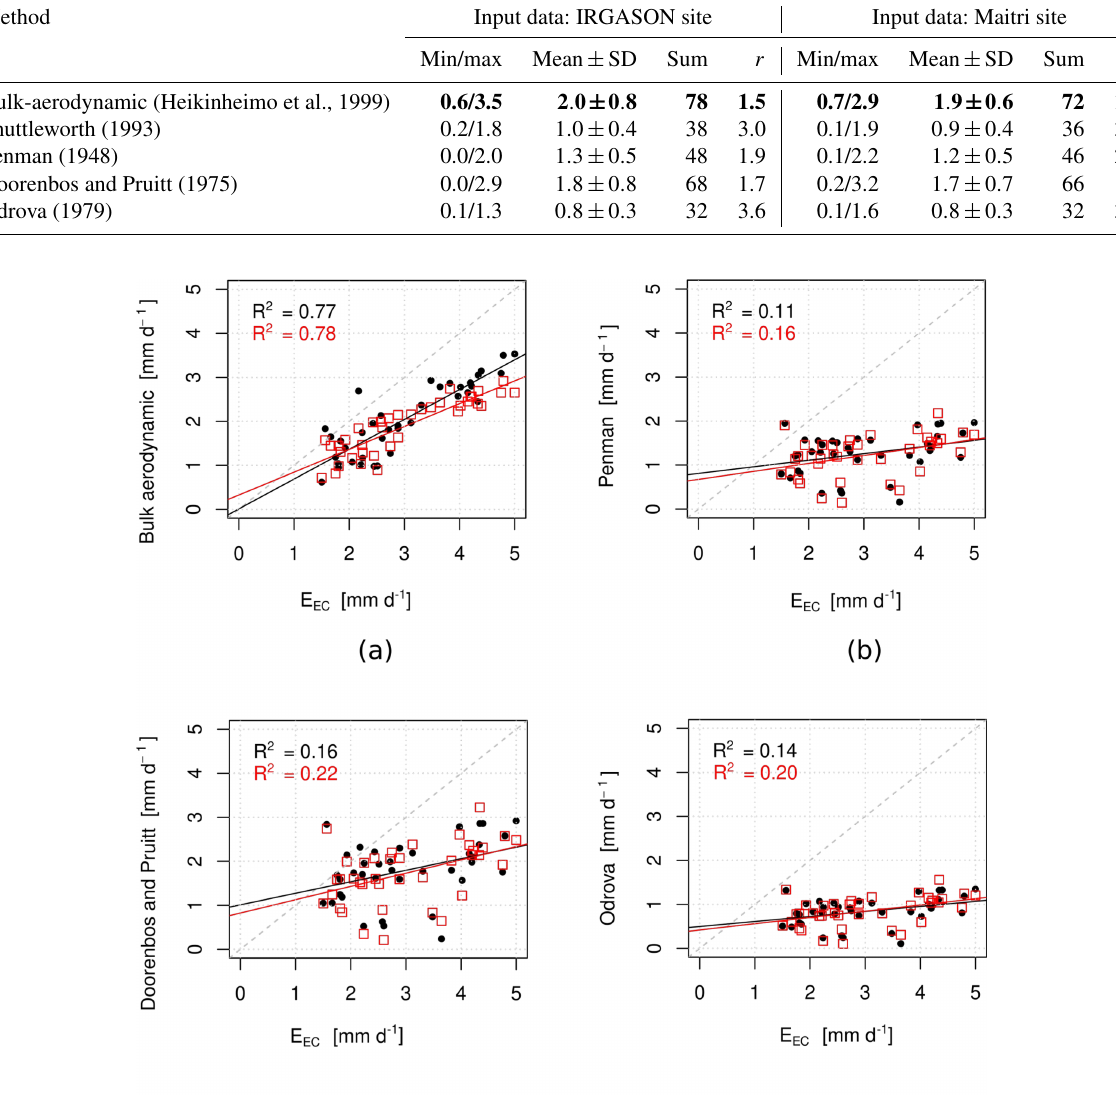
Table 3. The daily evaporation (mmd − 1 ) over the surface of Lake Zub/Priyadarshini for the period of 1 January–7 February 2018: SD is the standard deviation; r is the ratio between the sum E EC divided by the sum E mod . Bold: best estimate among the indirect methods.